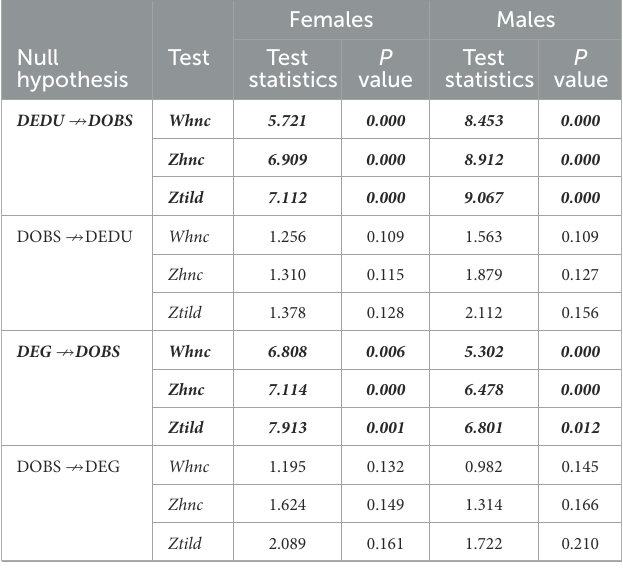
TABLE 7 Cointegration coefficient estimation.